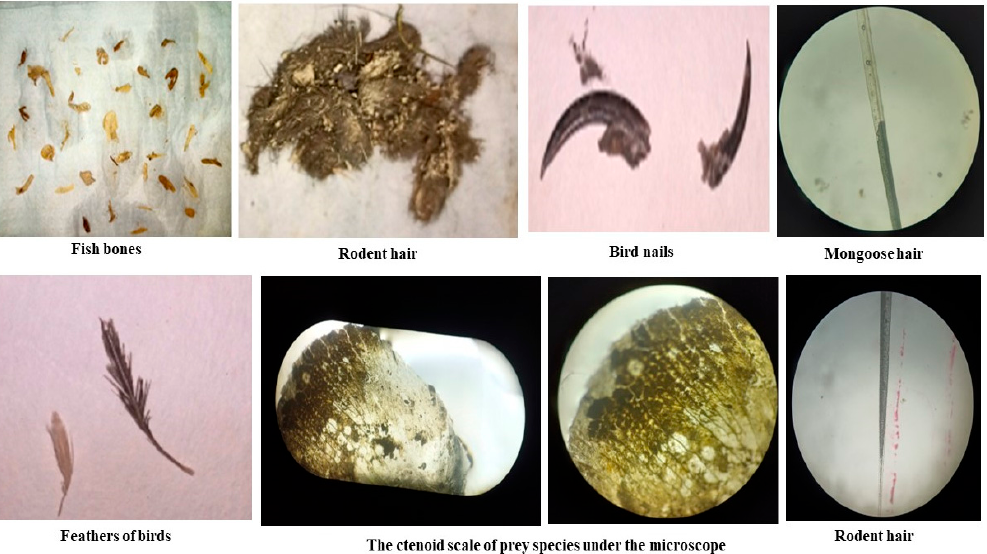
Figure 3. Prey matters of fishing cats found from their scat samples at five different sites of the study area.